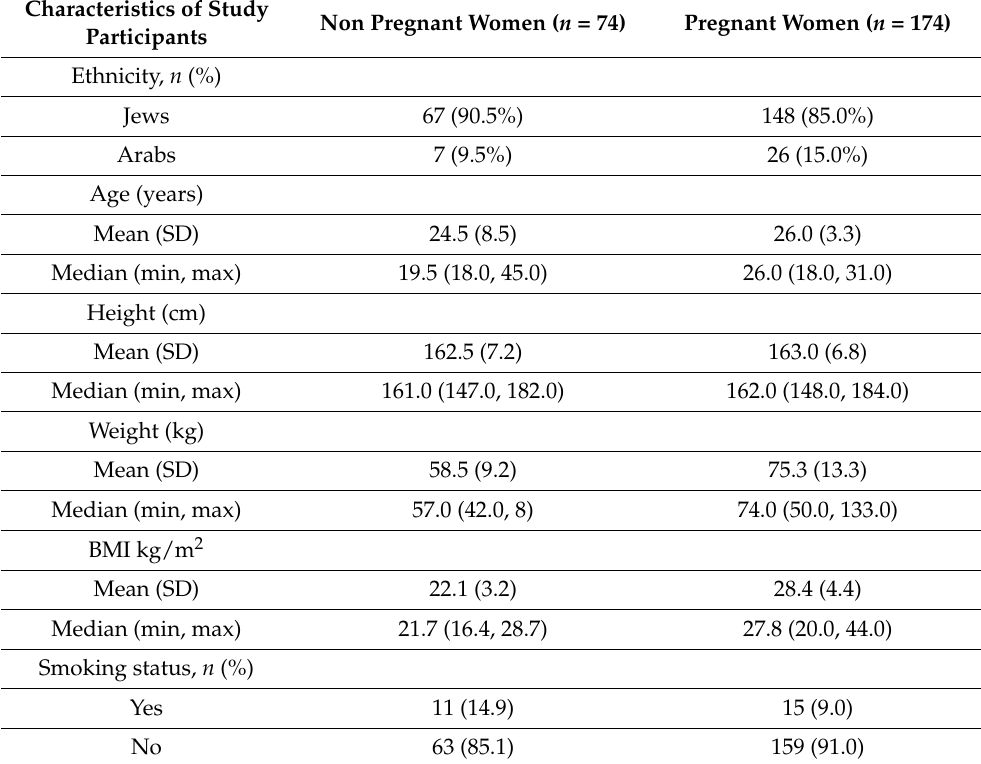
Table 1. Demographic and clinical characteristics of non-pregnant and pregnant women. Characteristics of